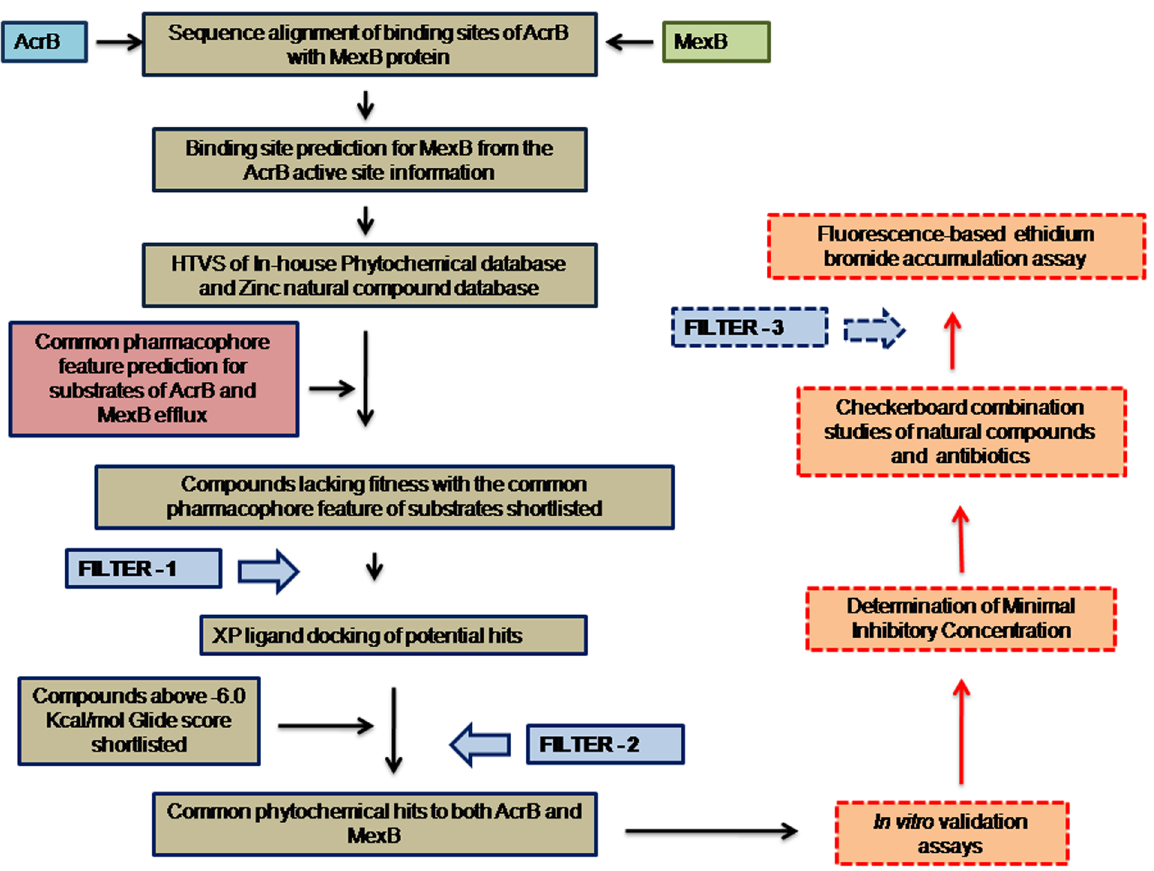
Figure 1. Flow chart of Virtual screening, pharmacophore-based filtering and experimental screening strategy for identifying efflux inhibitors.